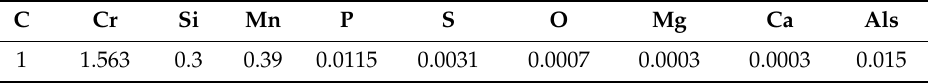
Table 1. Chemical composition of the GCr15 bearing steel used in the current study (mass %).